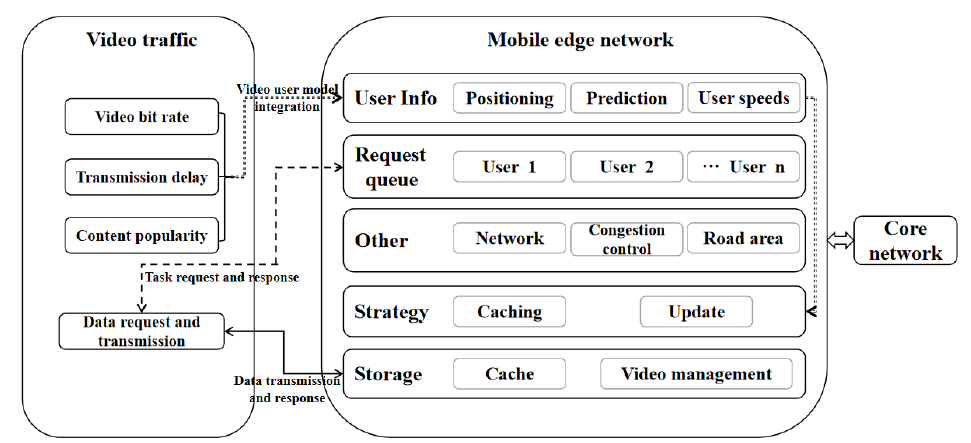
Figure 3. Integral system for edge caching of mobile video streaming.